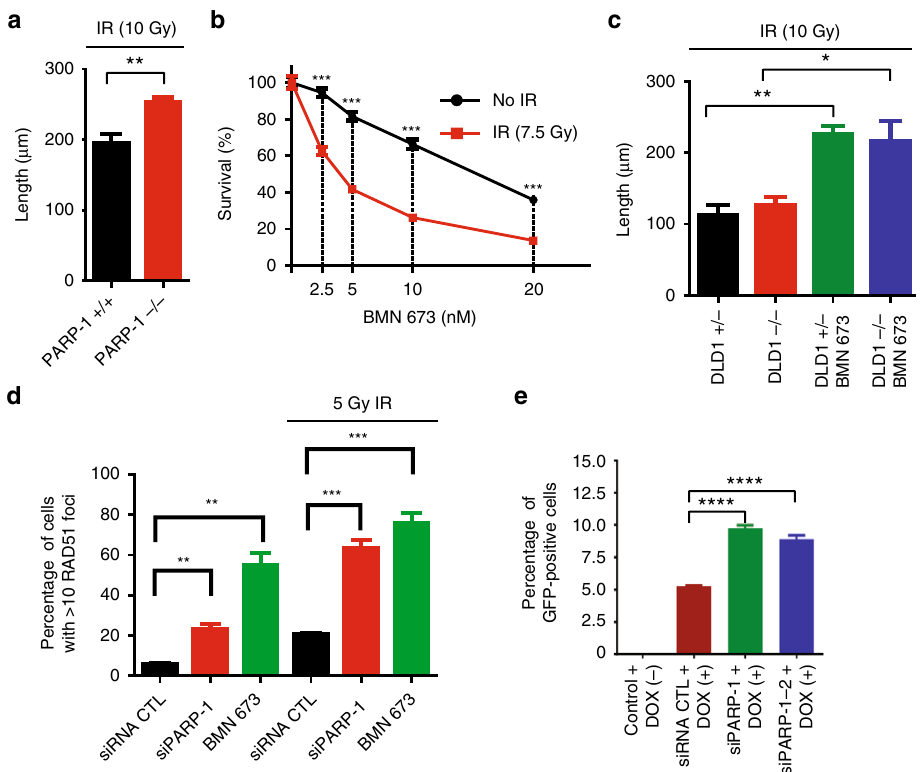
Fig. 7 Single-molecule analysis of resection tracks (SMART) analysis and effect of poly(ADP-ribose) polymerase-1 (PARP-1) on homologous recombination. a SMART of PARP-1-de fi cient mouse embryonic fi broblasts (MEFs). MEFs were treated with 10 Gy irradiation (IR). Error bars represent mean ± s.e.m. b Treatment of HeLa cells with BMN 673 results in IR sensitivity. Error bars represent mean with s.e.m. c SMART of BRCA2-pro fi cient (DLD1 BRCA2 ( + / − )) and BRCA2-de fi cient cells (DLD1 BRCA2 ( − / − )) either mock treated of treated with BMN 673 (5 μ M) were irradiated (10 Gy). Error bars represent Mean with s.e.m. d Attenuation of PARP-1 increases RAD51 foci in cellulo. Error bars represent mean ± s.e.m. e Homologous recombination is increased in PARP-1 knockdown cells. Error bar represents mean ± s.d. * p ≤ 0.05, ** p ≤ 0.01, *** p ≤ 0.001, **** p ≤ 0.0001 (Mann – Whitney U test).